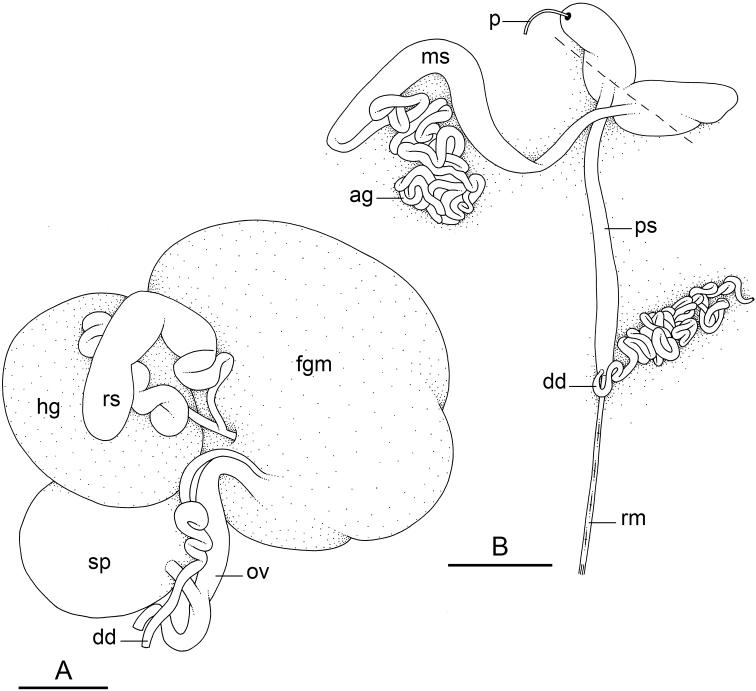
Reproductive system, Peronia
verruculata, Red Sea, spm #1 (ZMH 27472/4) A posterior, hermaphroditic (female) reproductive system B anterior, male, copulatory apparatus. Scale bars: 2 mm (A), 4 mm (B). Abbreviations: Abbreviations: ag accessory penial gland, dd deferent duct, fgm female gland mass, hg hermaphroditic gland, ms muscular sac, ov oviduct, p penis, ps penial sheath, rm retractor muscle, rs receptaculum seminis, sp spermatheca.